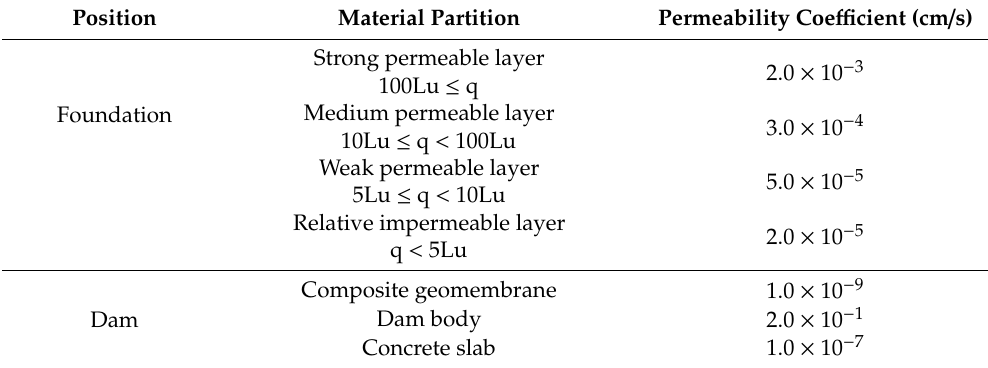
Figure 8. Finite element mesh models: ( a ) the whole dam; ( b ) the compound geomembrane. After the three-dimensional finite element calculations, considering steady seepage under two calculation conditions (a normal level and the designed flood level conditions), the potential distribution of the seepage field and seepage flux during the operational period are obtained as shown in Figure 9 and Table 4. Figure 9 reveals that the dam foundation and dam body below the phreatic line are in a saturated state.